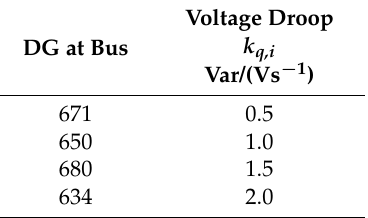
Table 5. The Coefficients of Primary Controller based on Consensus